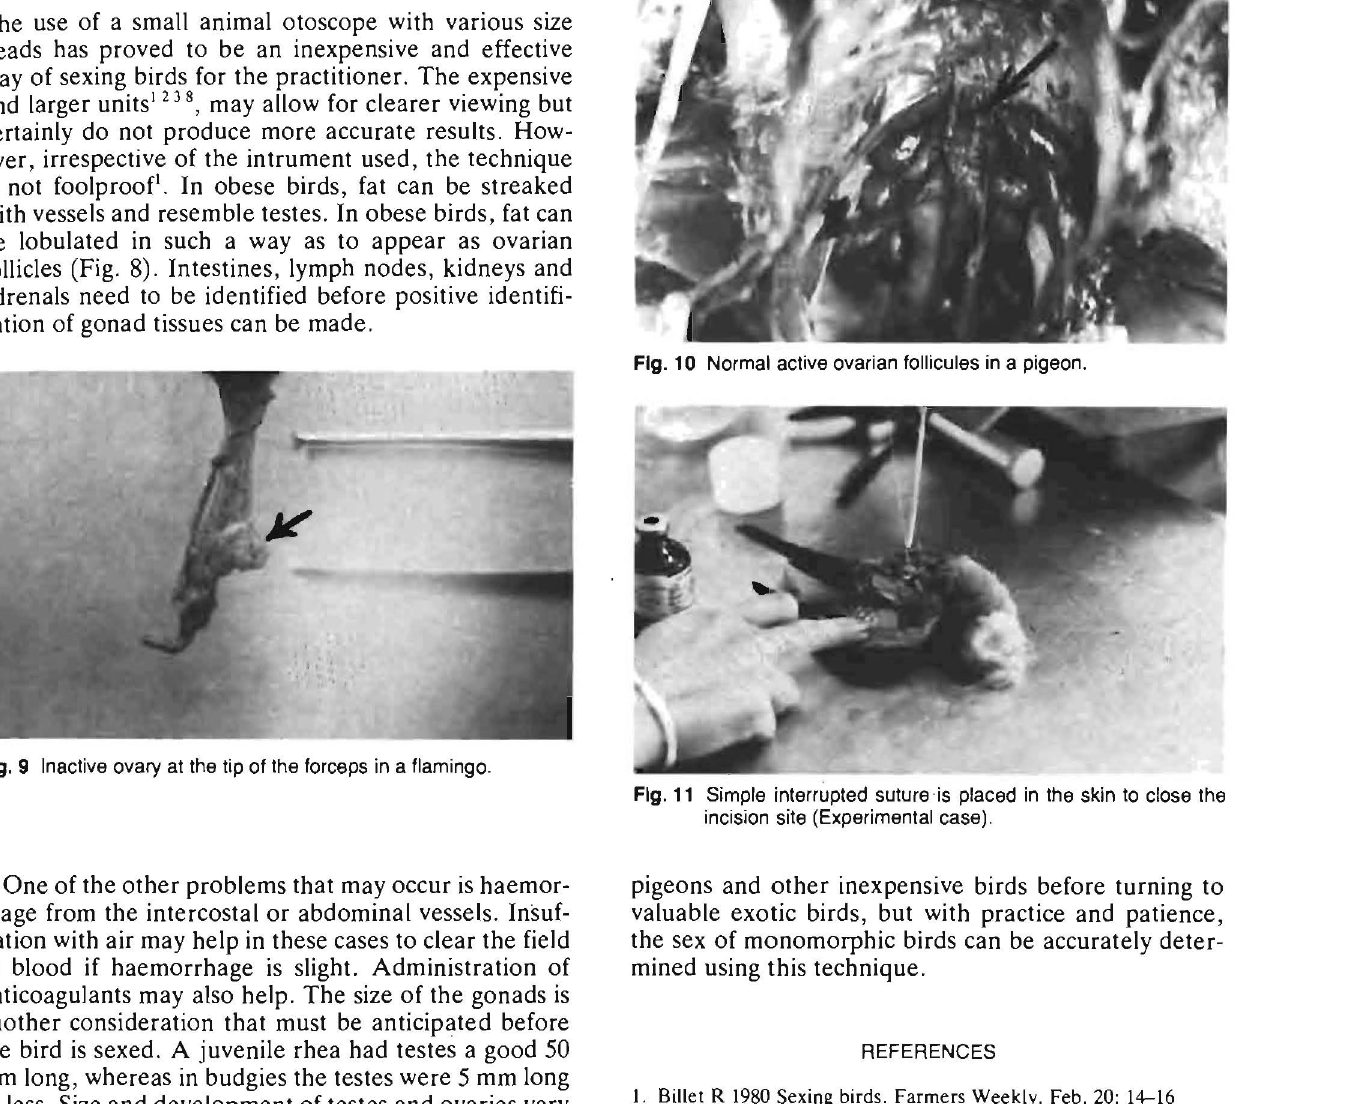
Fig. 10 Normal active ovarian follicules in a pigeon.